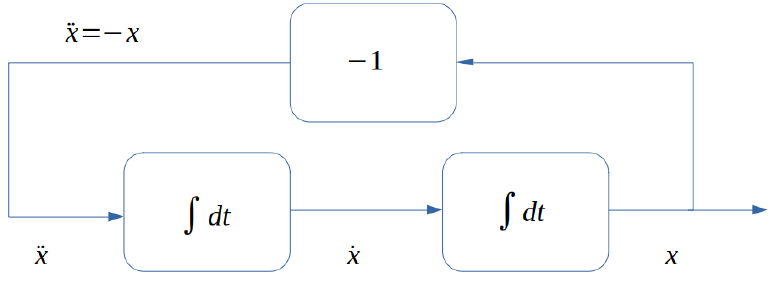
Figure 6. Basic implementation scheme of a coupled second order ODE, as in Equation (7).